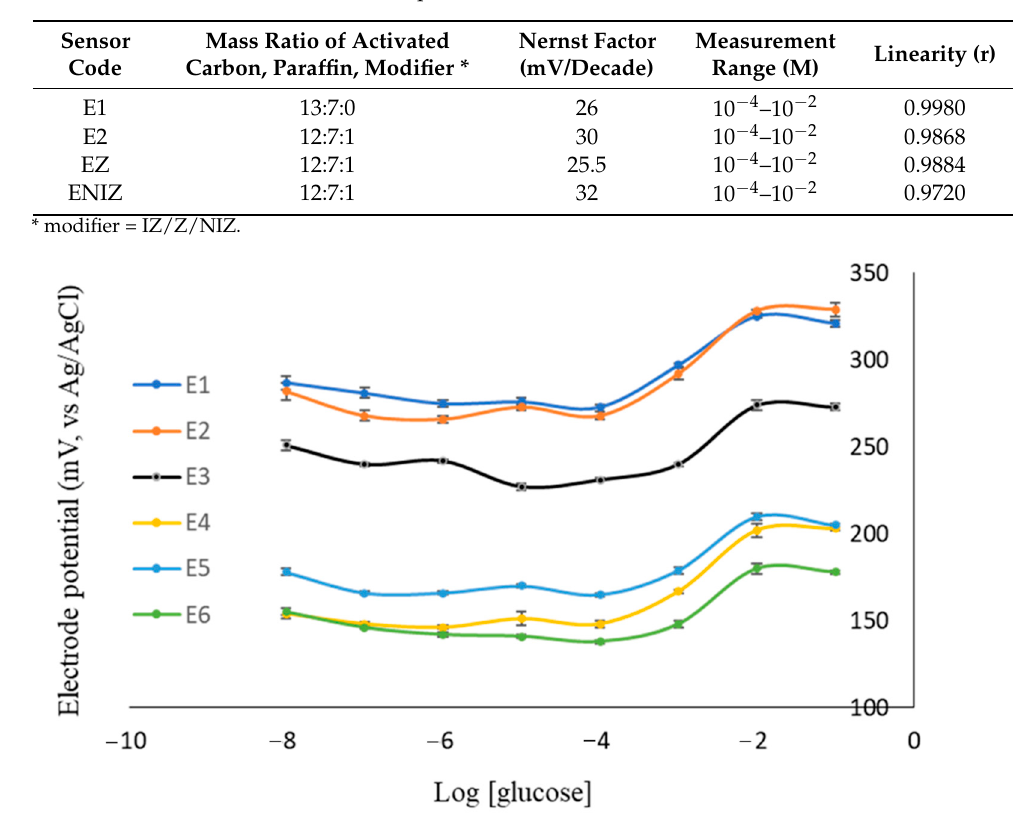
Table 4. Data on E1, E2, EZ, and ENIZ performances.